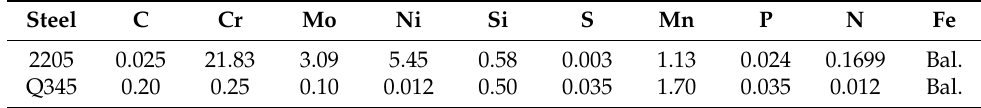
Table 1. Chemical composition of experimental steel (mass fraction, %).